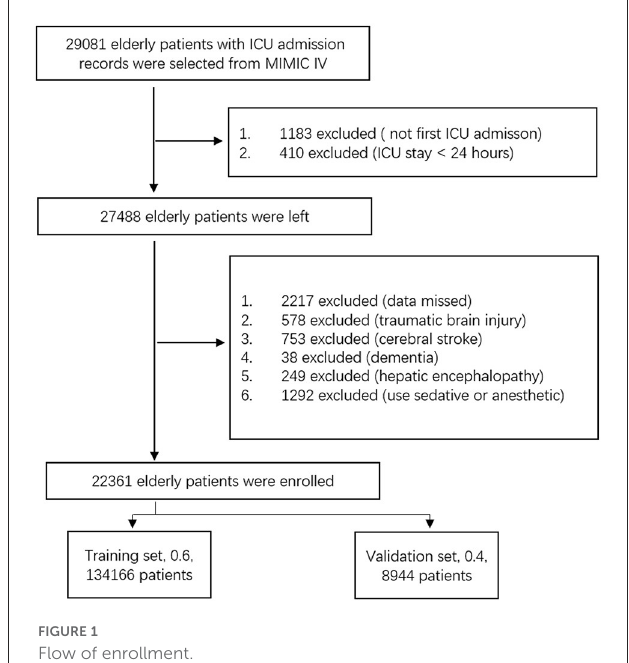
FIGURE1 Flow of